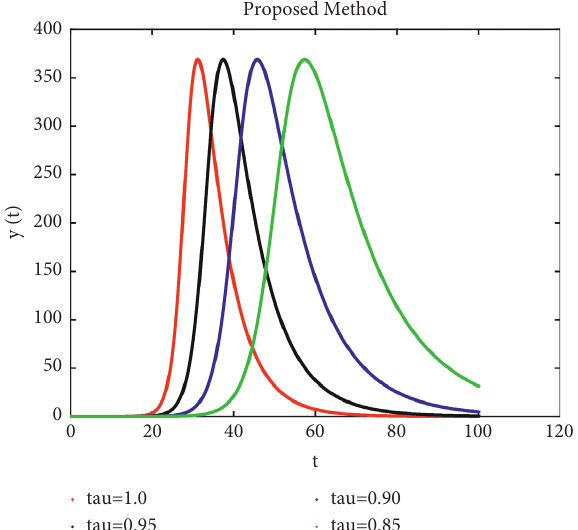
Figure 17: Dynamical behavior of infected cells at α � 1 and various fractal order � 0.85, 0.9, 0.95, 1 under Mittag-Leffler kernel.